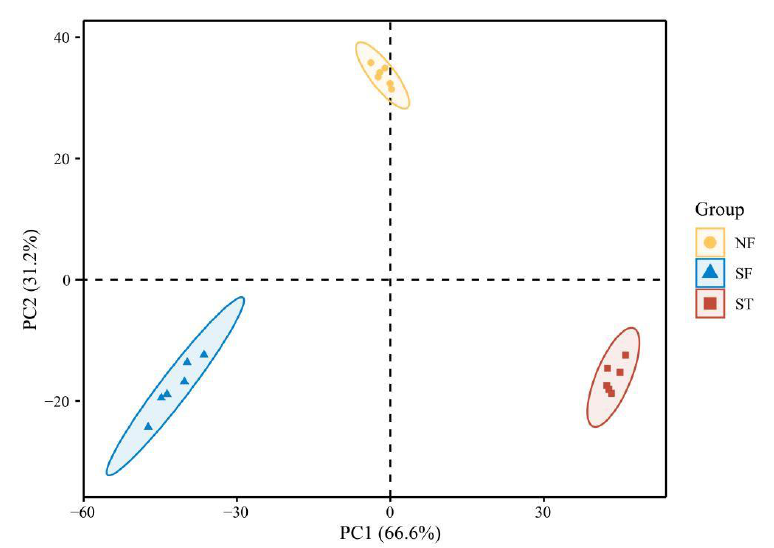
Figure 8. Principal coordinate analysis (PCoA) scatter plot analysis of two groups of samples. Note: yellow represents the natural fermentation group (NF); blue represents the starter fermentation group (SF); red represents the sterilization group (ST).